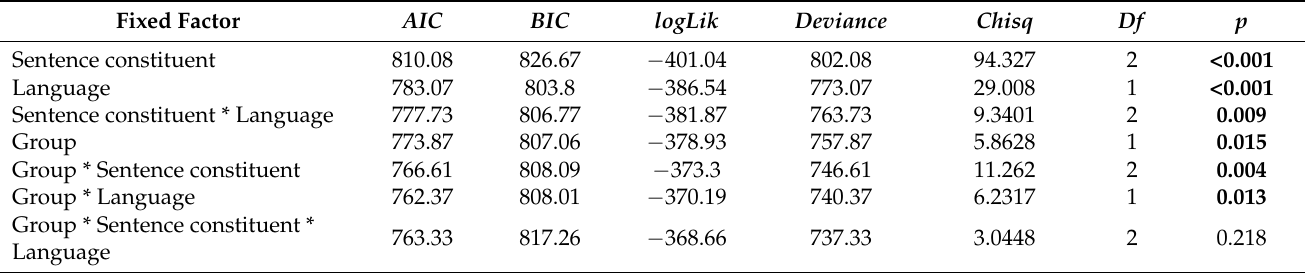
Table A2. Estimates of the GLMM model predicting the frequency of non-targeted CS by Sentence constituent.